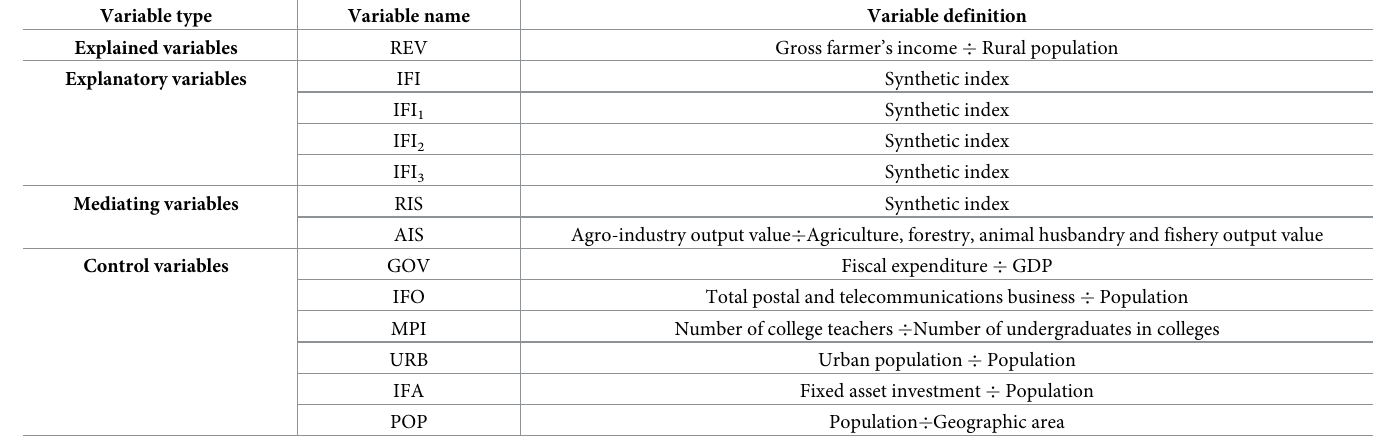
Table 2. Variable